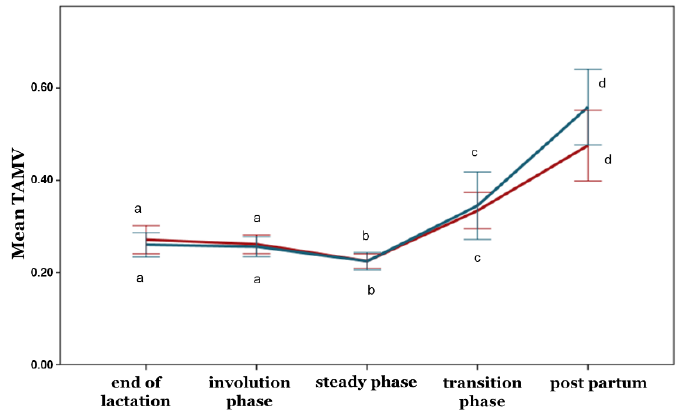
Figure 7. Time-averaged maximum velocity changes among the periods and between the ewe groups ( p ≤ 0.05). The different letter indicators (a, b, c, d) represent statistically significant differences between the periods. The green line represents the ewe group with healthy udders, while the red represents the ewe group with subclinical mastitis.